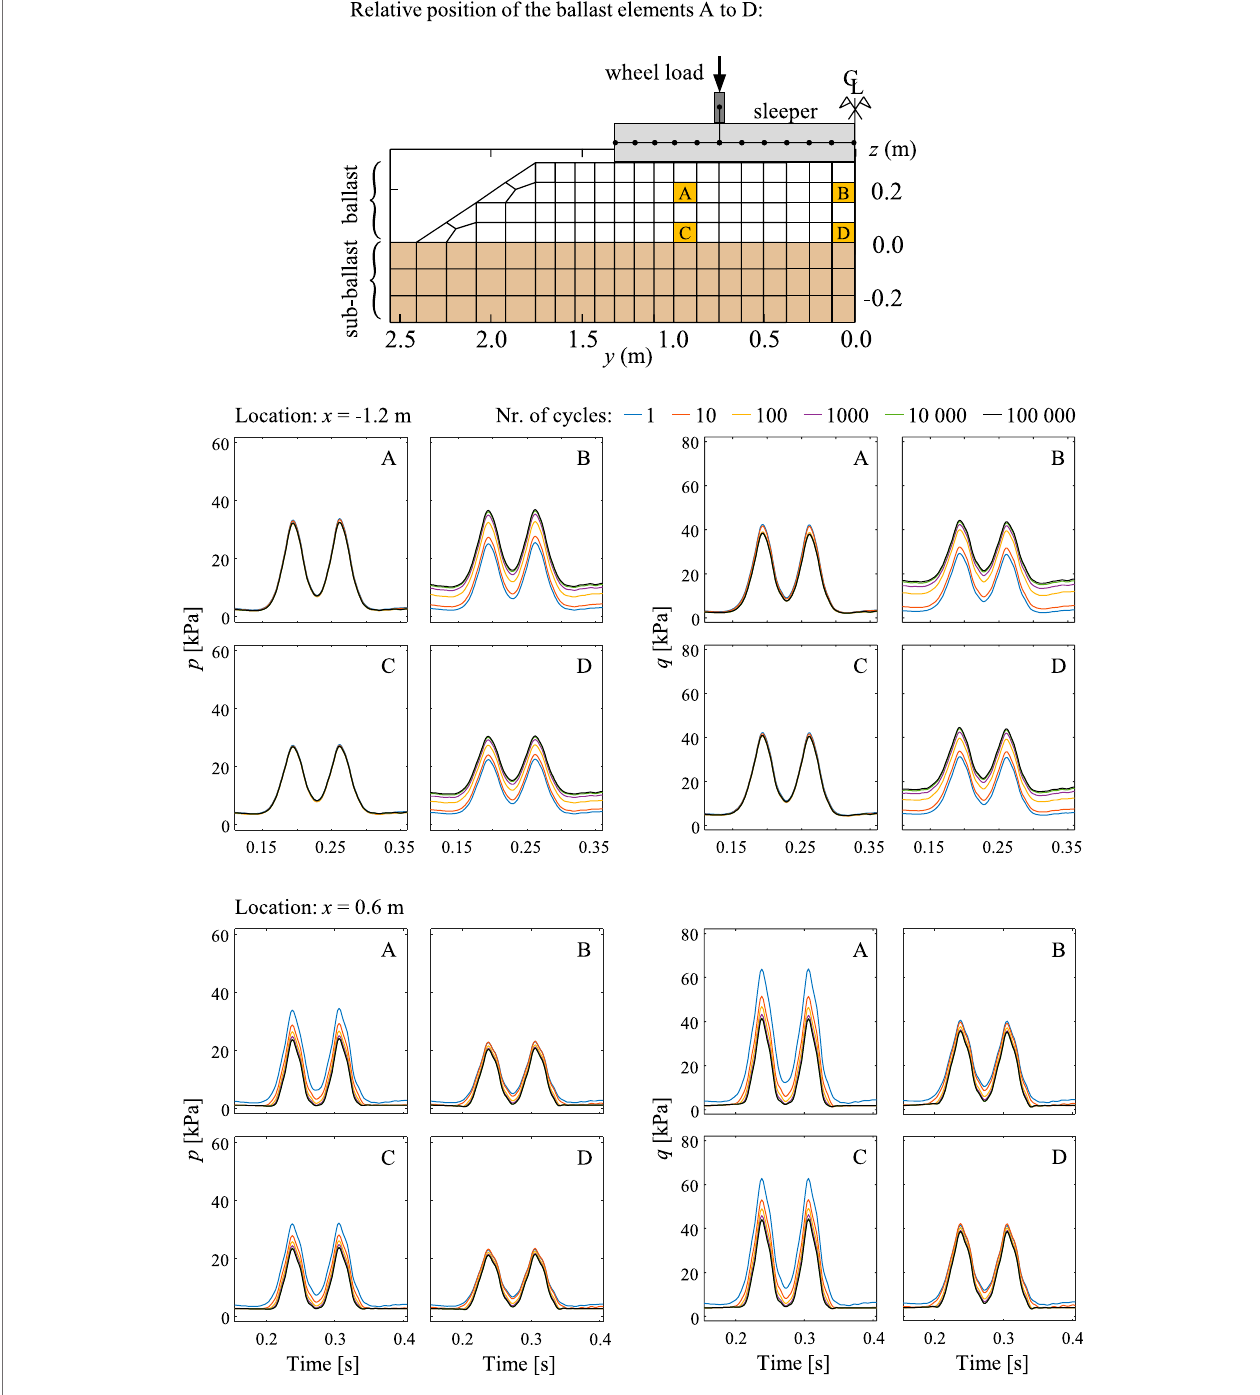
FIGURE 13 | Transient variation of p (left) and q (right) at positions (A – D) in the ballast layer, under the sleepers at positions x (cid:1) − 1 . 2 m and x (cid:1) 0 . 6 m .